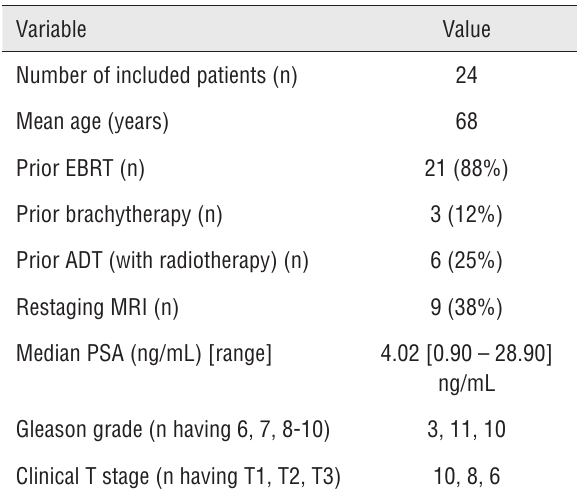
Table 1 - Baseline characteristics of